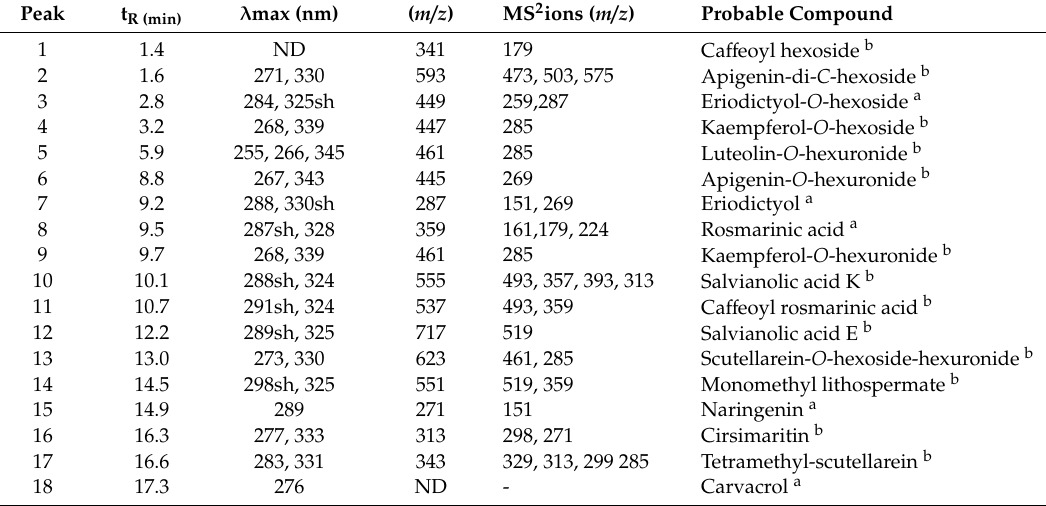
Table 3. Phenolic compounds identified by UHPLC-DAD-ESI-MS n in the methanolic extracts of Thymus algeriensis .